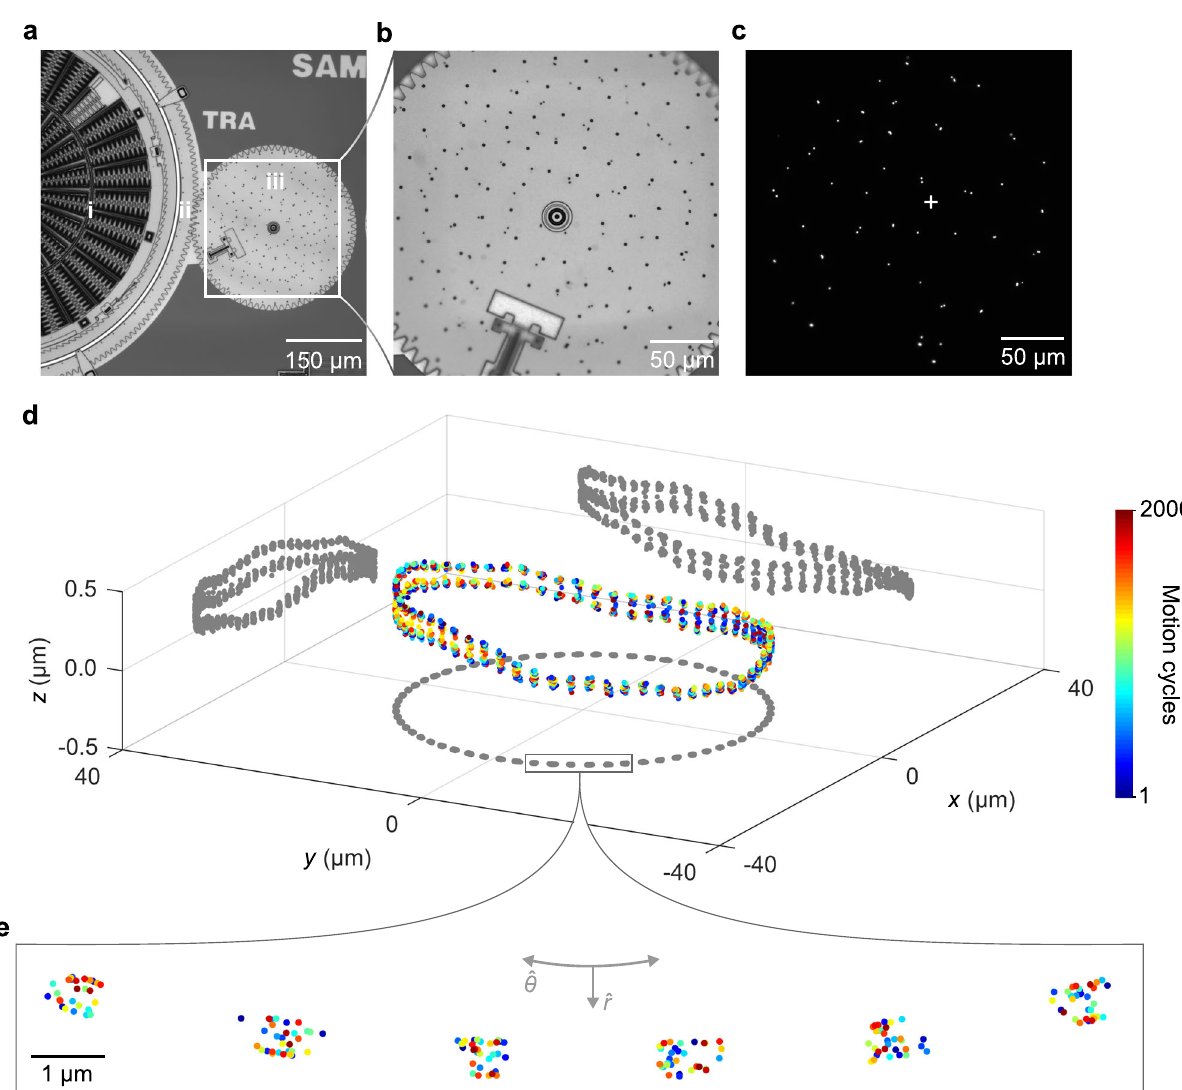
Fig. 6 Microsystem motion in three dimensions. a Bright fi eld micrograph showing the drive motor, consisting of (i) a rotational actuator, (ii) a ring gear, and (iii) the load gear. b Bright fi eld micrograph magnifying the load gear and particles. The smaller dots with random spacing are fl orescent particles and the larger dots with regular spacing are etch holes. c Fluorescence micrograph showing a constellation of fl uorescent particles on the surface of the load gear. The cross indicates the centroid of the subset of particles that we use for tracking. d Scatter plot showing the trajectory of the centroid of the particle constellation in three dimensions. Tilt is apparent. The position clusters in the x and y directions are due to the nature of the ratchet mechanism that rotates the load gear through 64 nominal orientations with each revolution. e Scatter plots showing centroid positions in the x - y plane for the nominal locations within the box in ( d ). Uncertainties for both lateral and axial positions are smaller than the data markers. a © 2020 IEEE. Reprinted, with permission, from Ref. 32 .